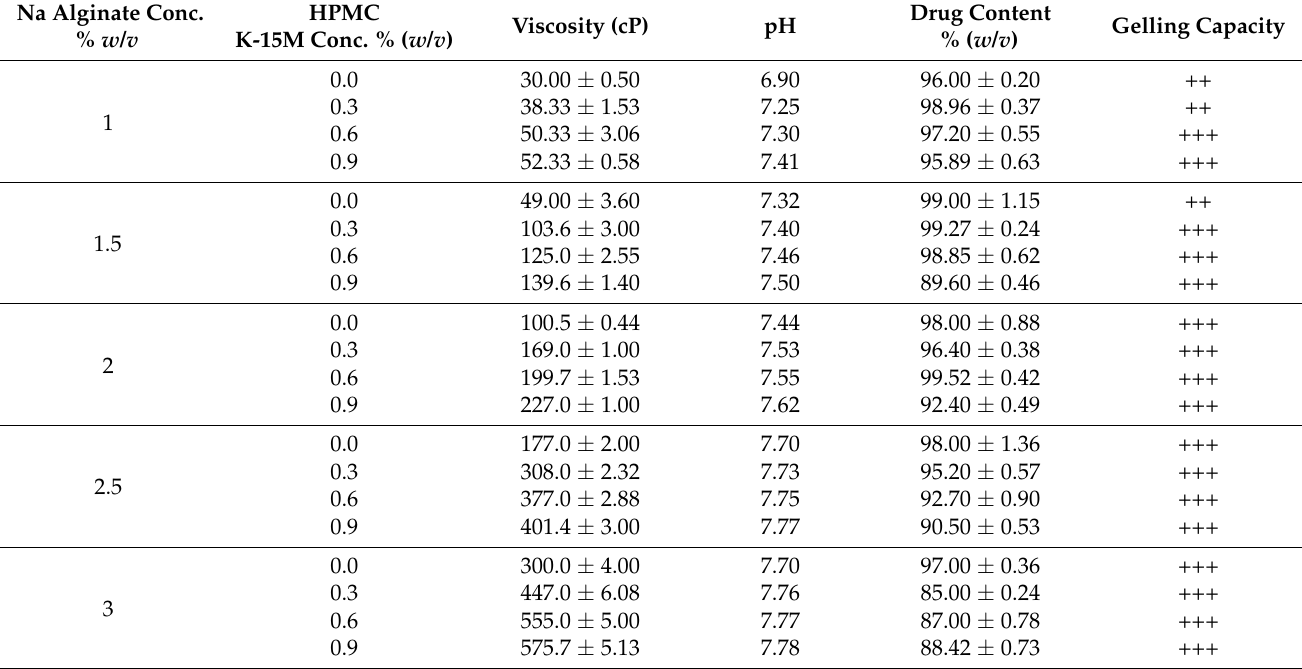
Table 1. Composition of the in situ gel formulations, their viscosity, pH, drug content, and gelling capacity. Na Alginate